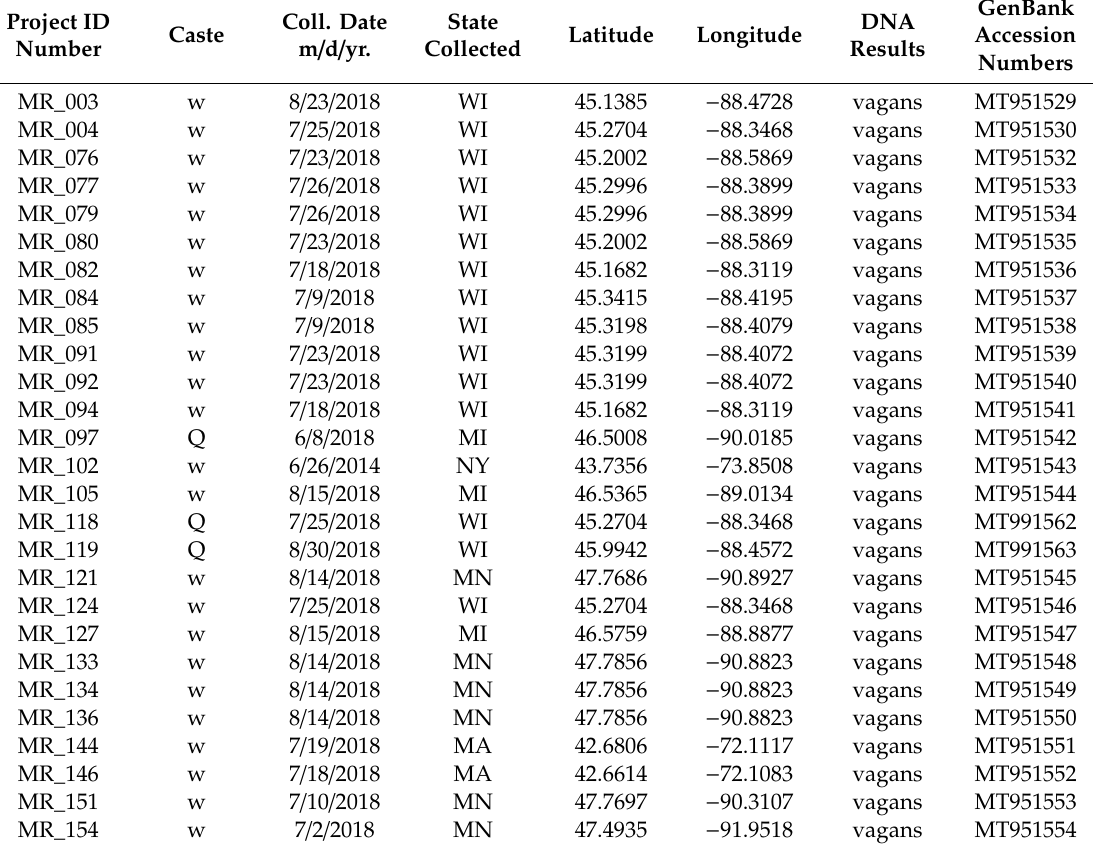
Table A1. Project bumble bee specimens for determining ratios of MRL, MR1, and MR3 presented by project number, caste, collection date, collection state, latitude, longitude, verified DNA results, and GenBank Accession